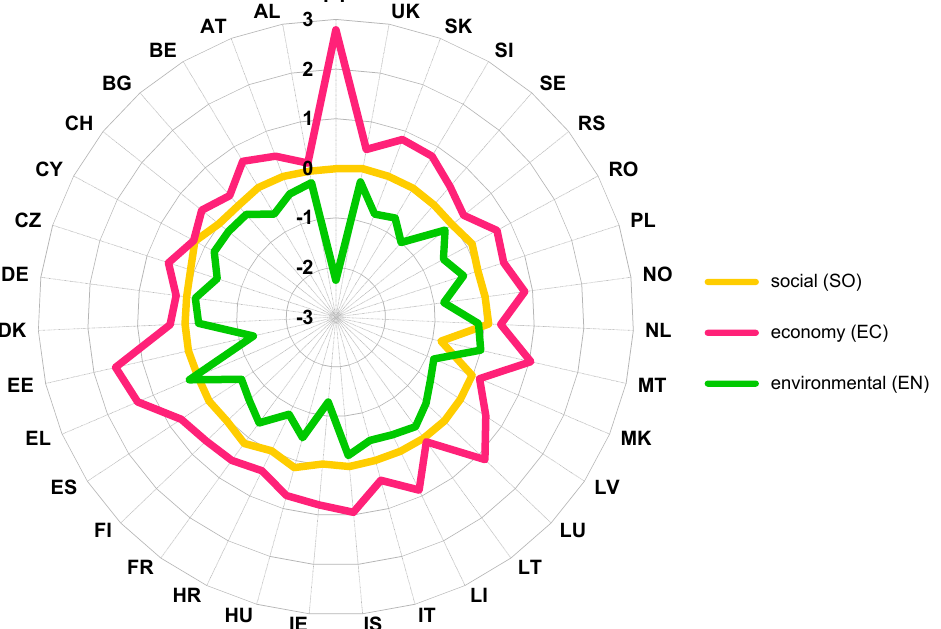
Figure 5. Sustainability assessment of local change directions in rural areas.